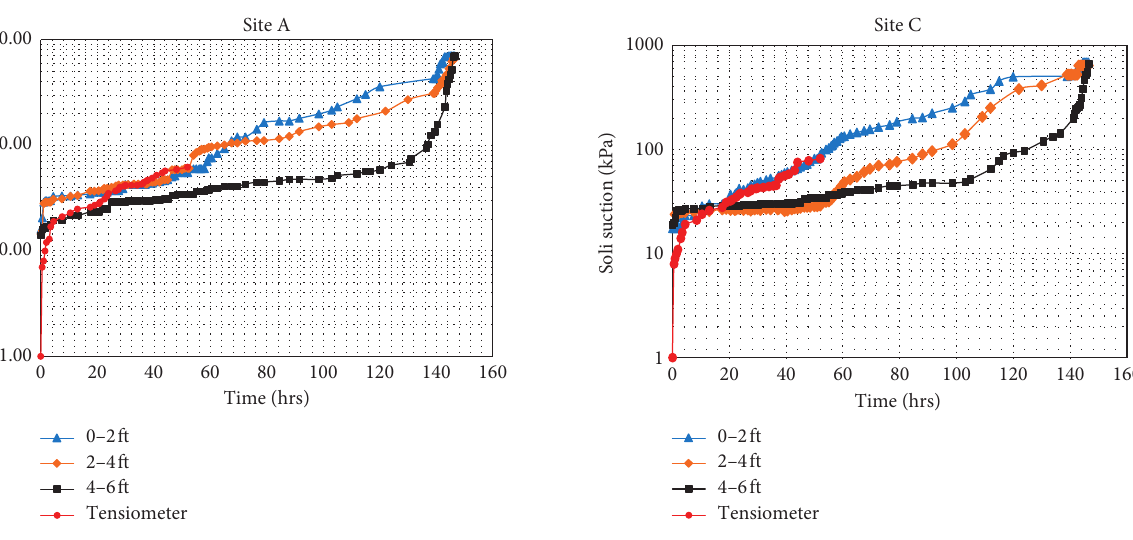
Figure 10: Typical curves showing the variation of suction with time for site A.